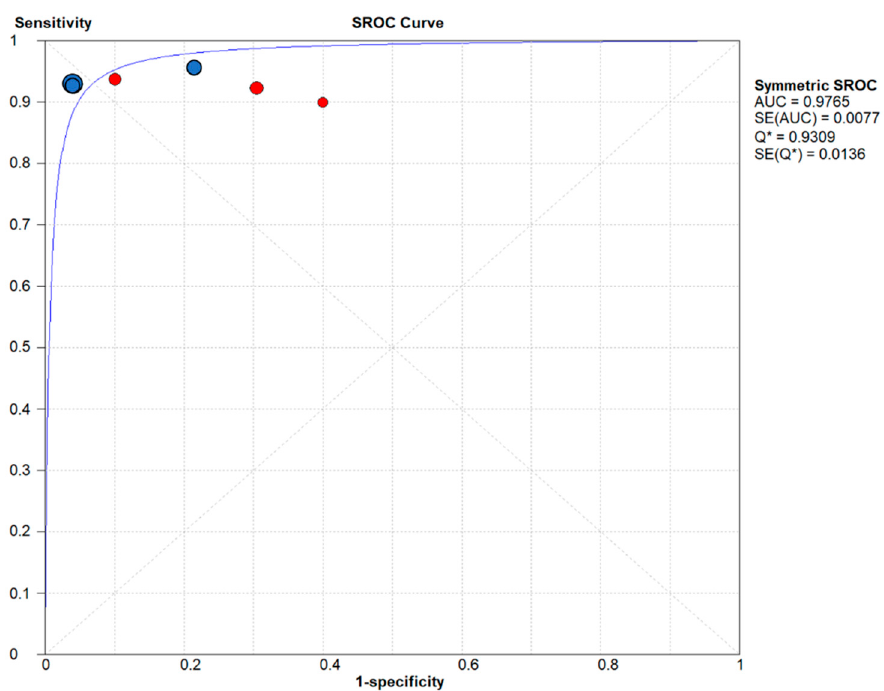
Figure 4. Summary receiver operating characteristic (sROC) curve for the six included studies. The area under the ROC summary curve was observed to be approximately 1.0. The sROC synthesis was based on pooled sensitivity, pooled specificity and respective variances. The size of each point is proportional to the study sample size or the weight of the study in the meta-analysis. The blue points represent studies with Accumap equipment and the red points are with Veris equipment. AUC = Area Under the Curve. Q = Index Q. SE = Standard Error.